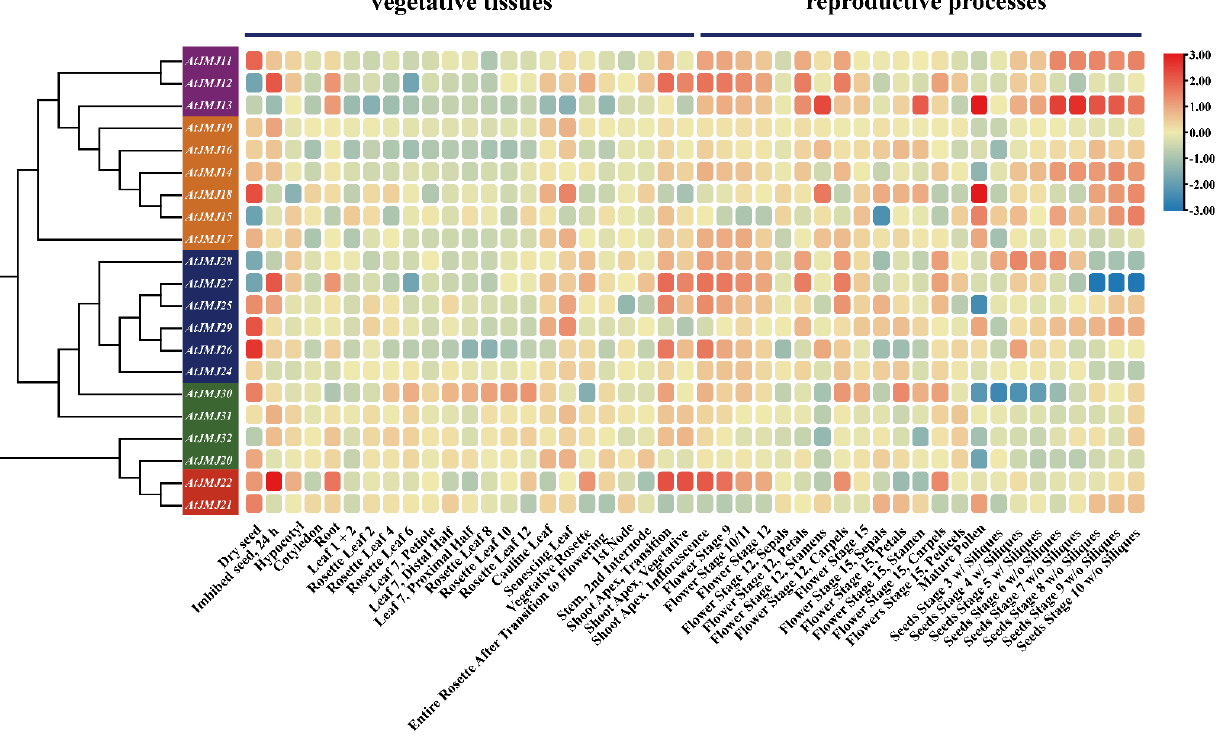
Figure 5. Expression profiles of the JmjC genes in different tissues and developmental stages of A. thaliana . On the left is the phylogenetic tree of Arabidopsis JmjC s.